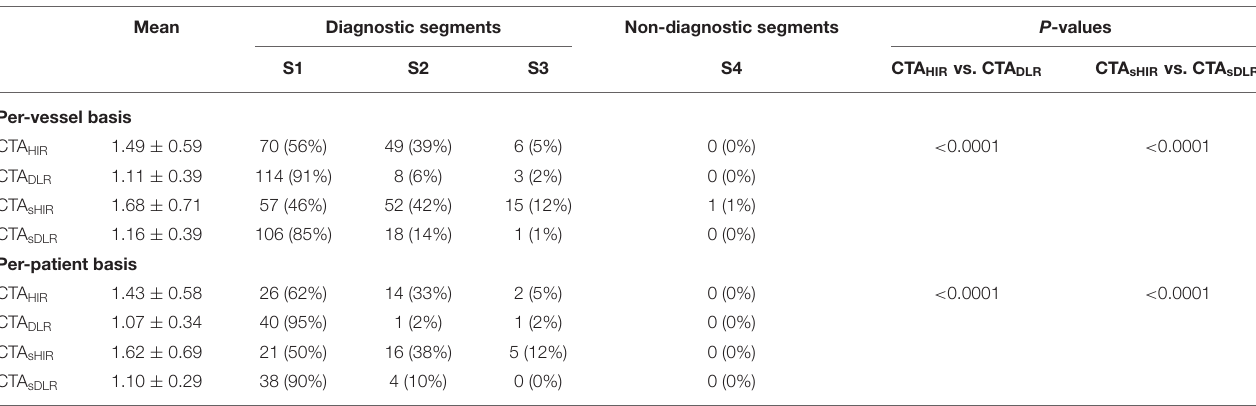
TABLE 2 | Qualitative image quality